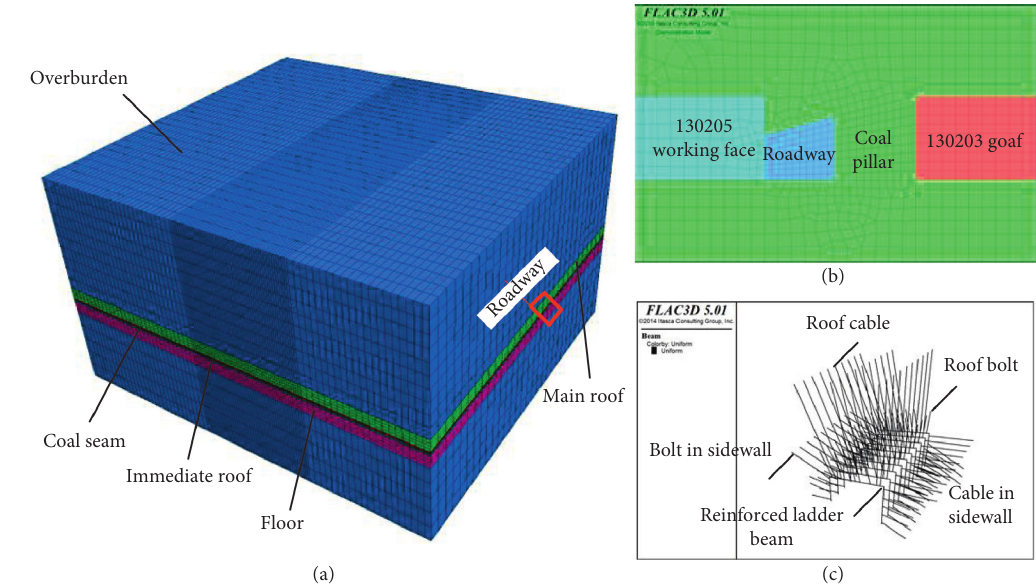
Figure 4: Grid diagram of the three-dimensional numerical model.